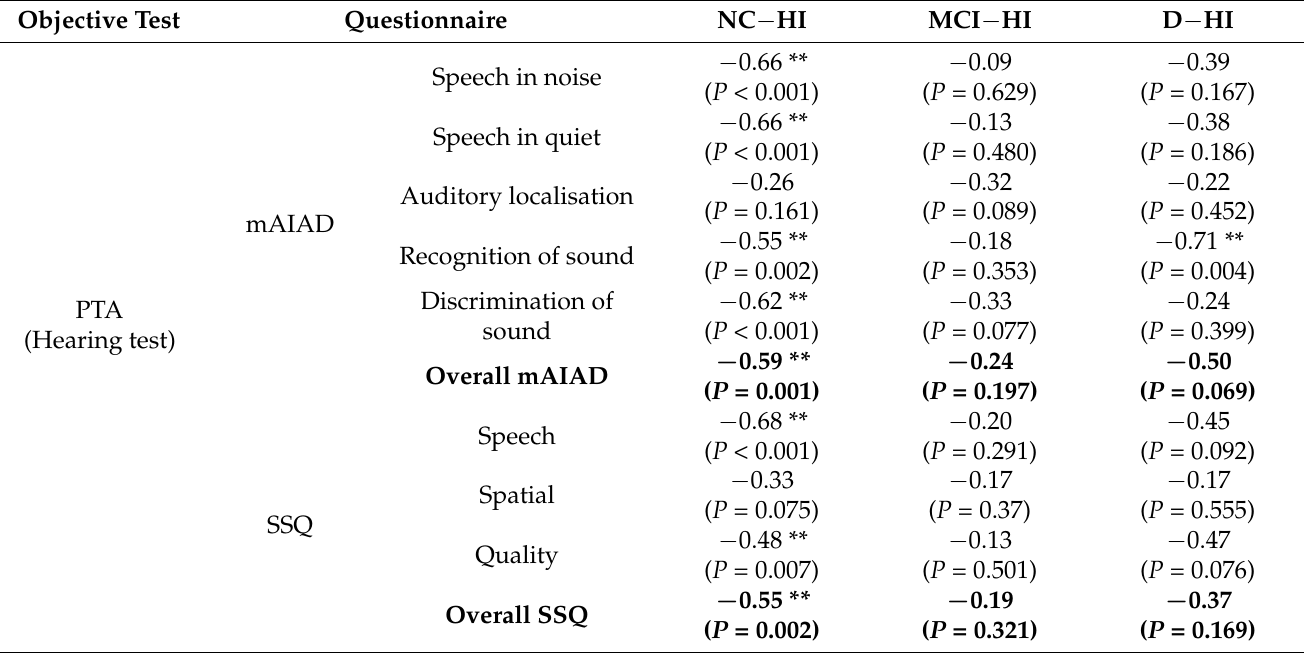
Table 3. Pearson correlation between the PTA and the score for self-report hearing questionnaires. Objective Test